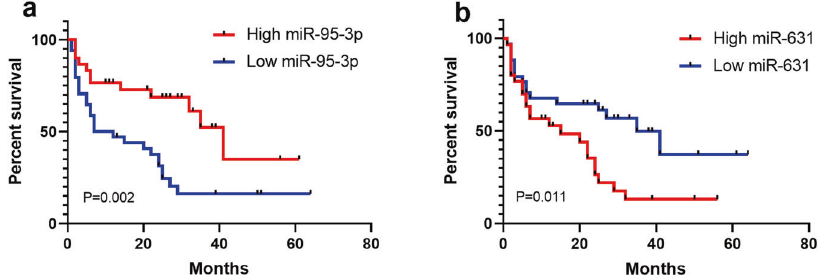
Fig. 4 Kaplan – Meier analysis of dialysis-free survival in patients with diabetic nephropathy. The subjects were dichotomized based on the mean of the covariates: a 0.822 for miR-95-3p; b 0.938 for miR-631. P values refer to log-rank